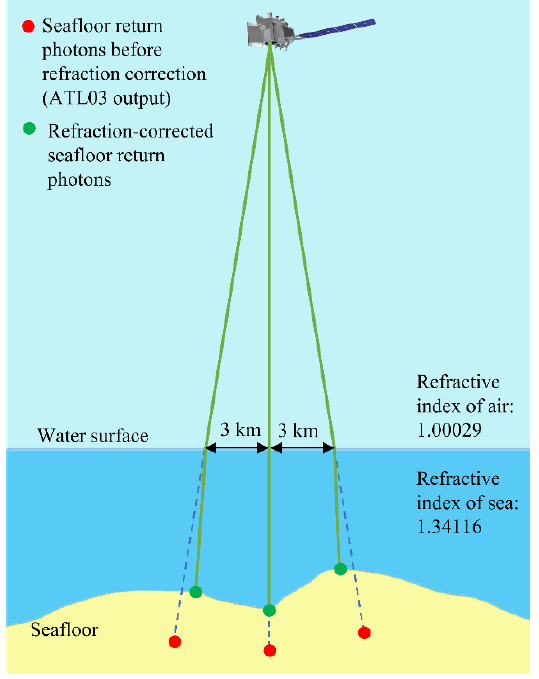
Figure 5. Illustration of refraction of the laser beams at the air – sea interface. Inspiration from [23,28].